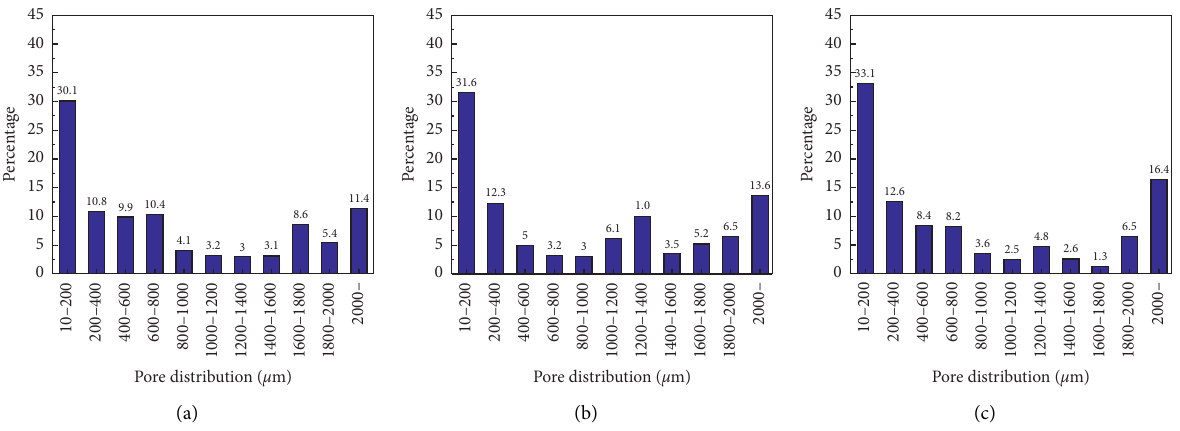
Figure 22: Pore size distribution of DSC with different freeze-thaw cycles. (a) 0 times. (b) 50 times. (c) 125 times.